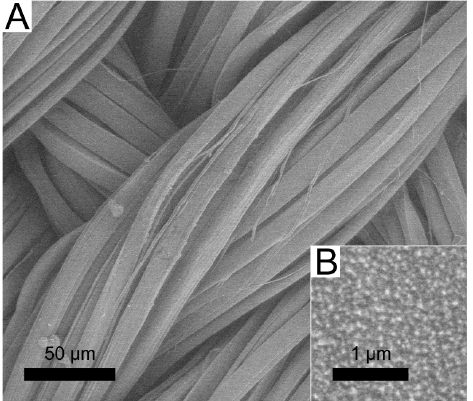
Figure 1. SEM micrograph of the synthetic silk cloth coated with DLC:Ag thin film ( A ), close up view of the film ( B ).